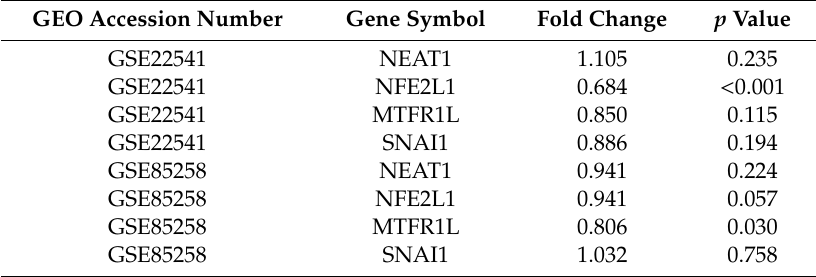
Table 5. The association between miRNA expression and survival